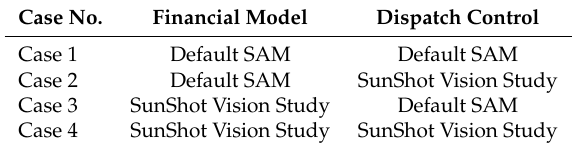
Table 6. Cases showing different combinations of Dispatch Control and Financial Models. Case